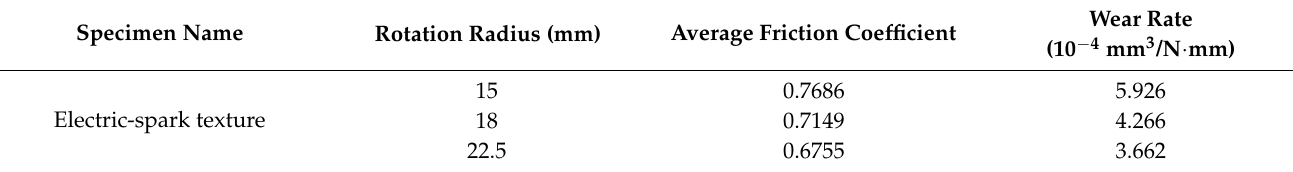
Table 5. Average friction coefficient and wear rate of different